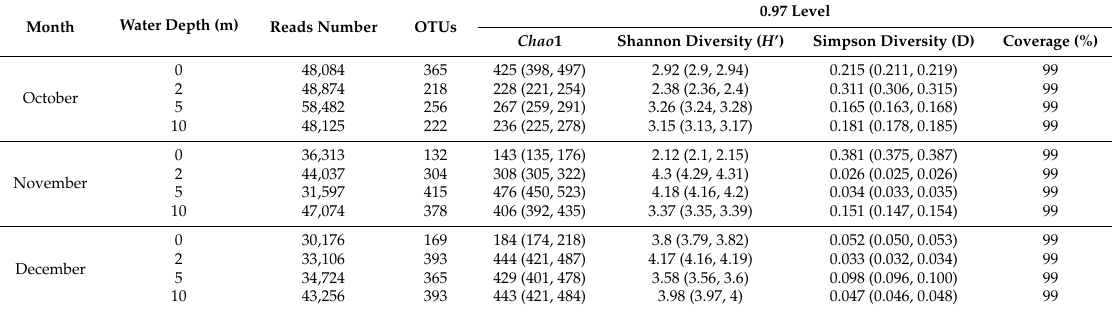
Table 3. Eukaryotic community diversity and richness estimators of Jinpen reservoir from October